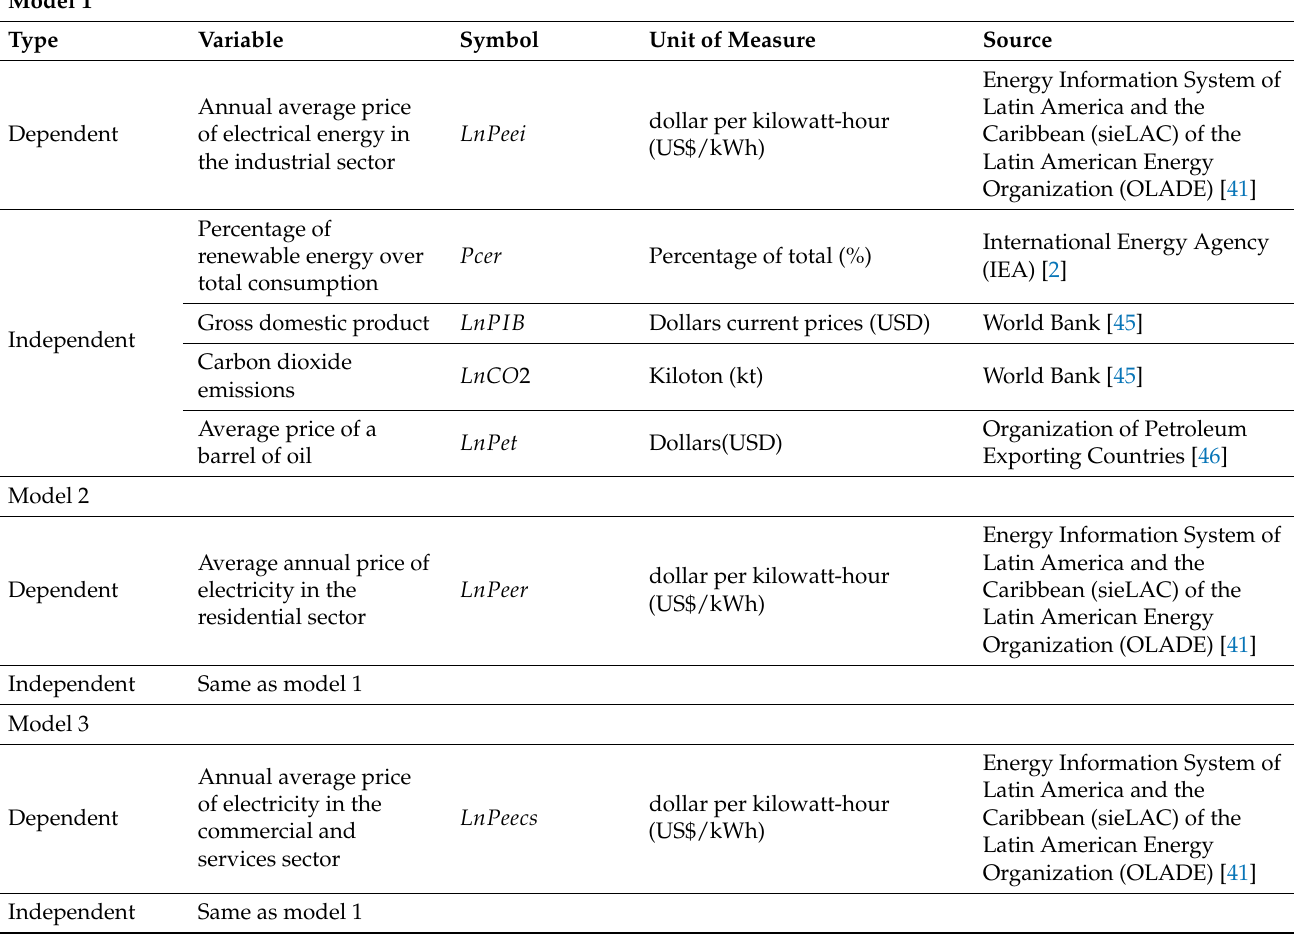
Table 1. Dependent and independent variables of the models to be